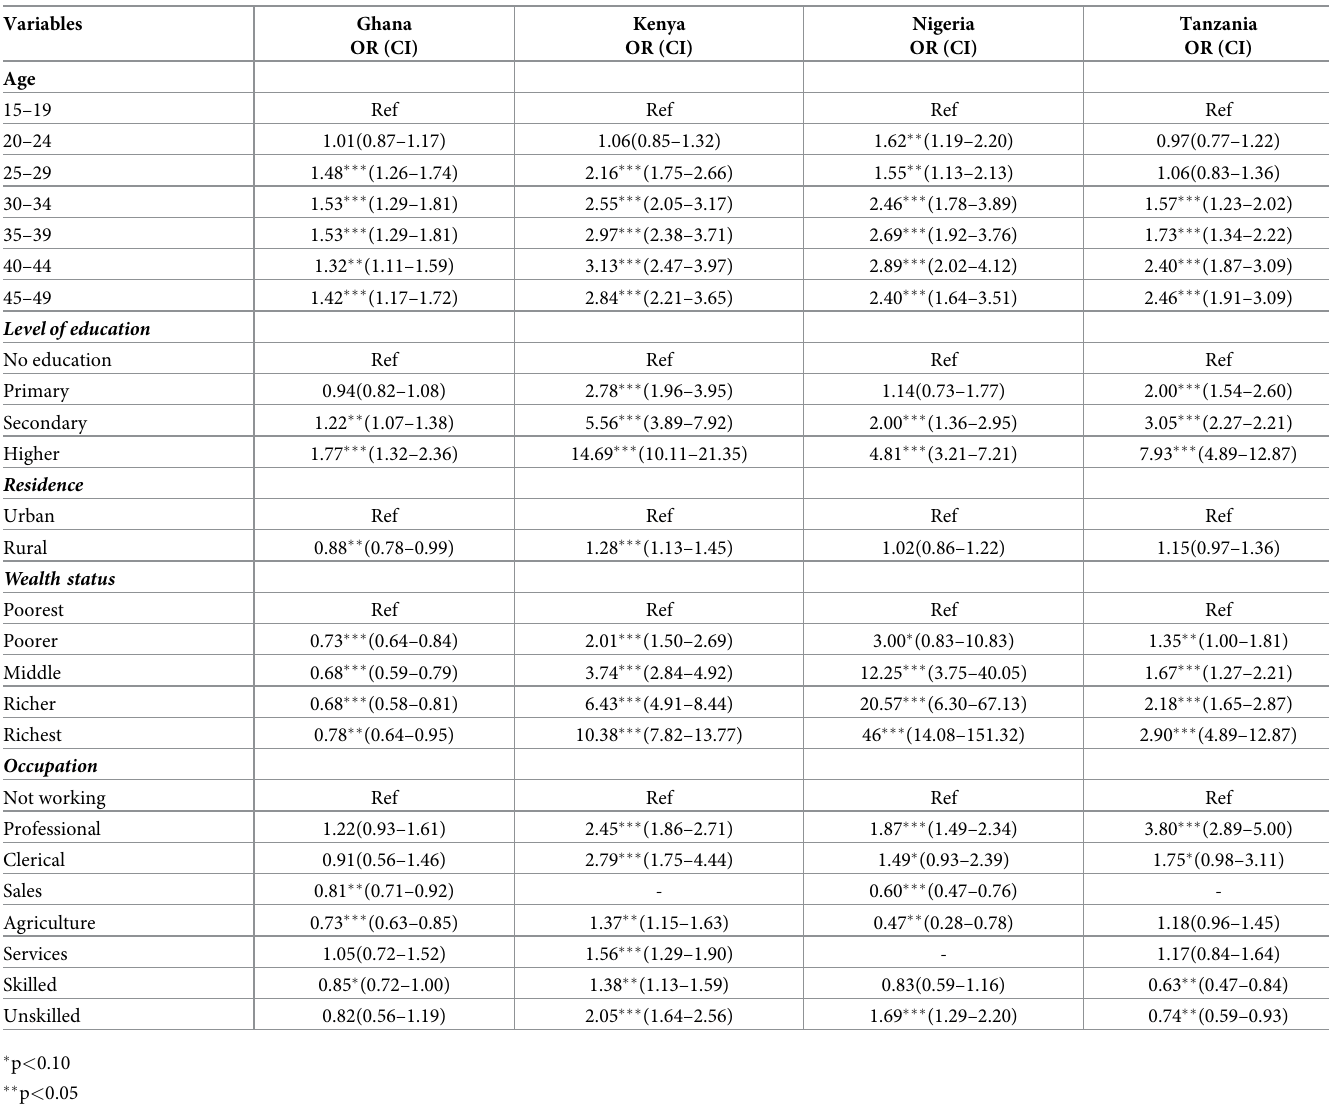
Table 3. Multivariate logistic regression on health insurance coverage